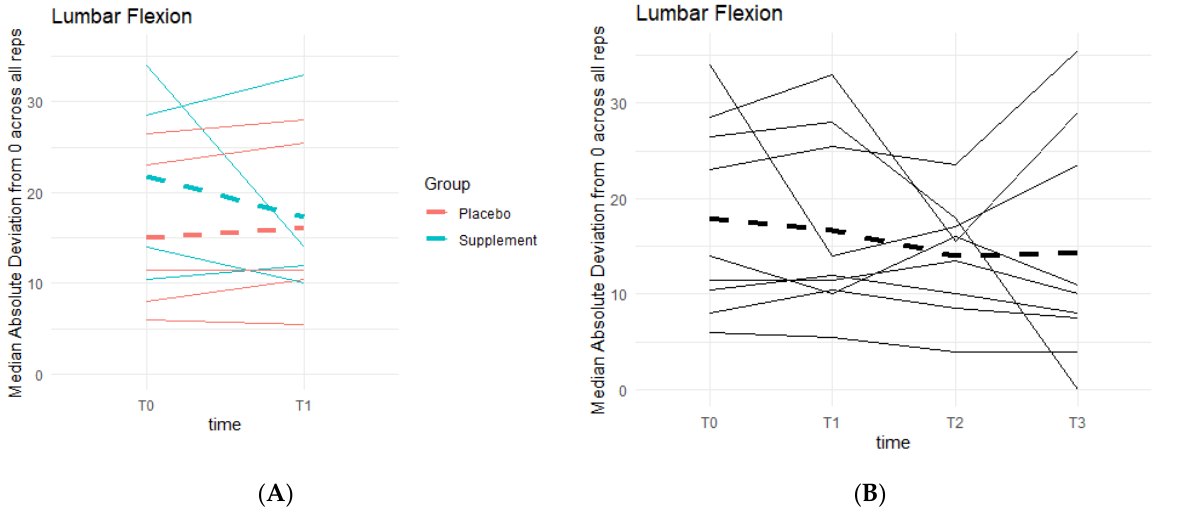
Figure 12. Squat Lumbar Flexion Deviation Changes. Lumbar flexion deviations were recorded. The median absolute deviations from 0 degrees across all repetitions as a function of time were then graphed. ( A ) compares Supplement vs. Placebo Groups from T0 to T1. ( B ) shows averages for the entire cohort at T0, T1, T2 and T3.